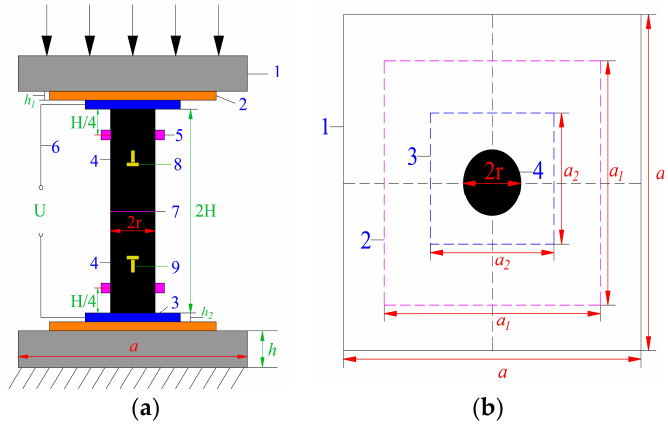
Figure 4. Schematic diagram of serial coal pillars model in the laboratory test. ( a ) Lateral